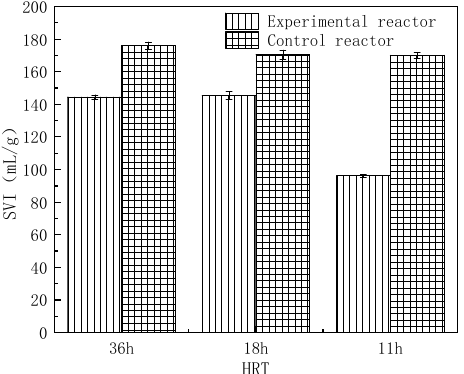
Figure 2. SVI changes of biofloc in both reactors under various HRTs .